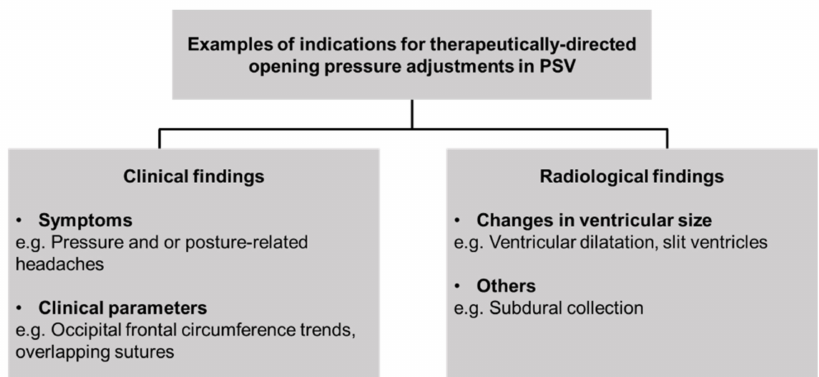
Figure 1. General overview of common indications for adjustments to PSV in study